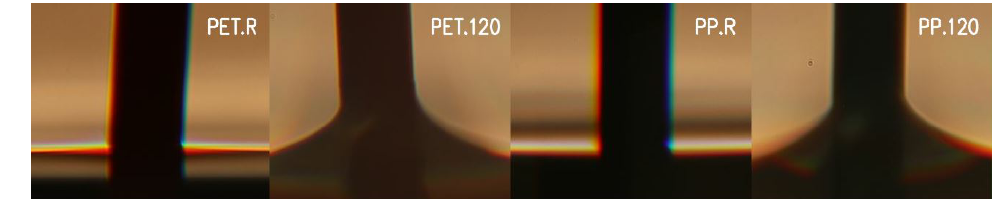
Figure 4. Contact angles captured during the wettability measurement